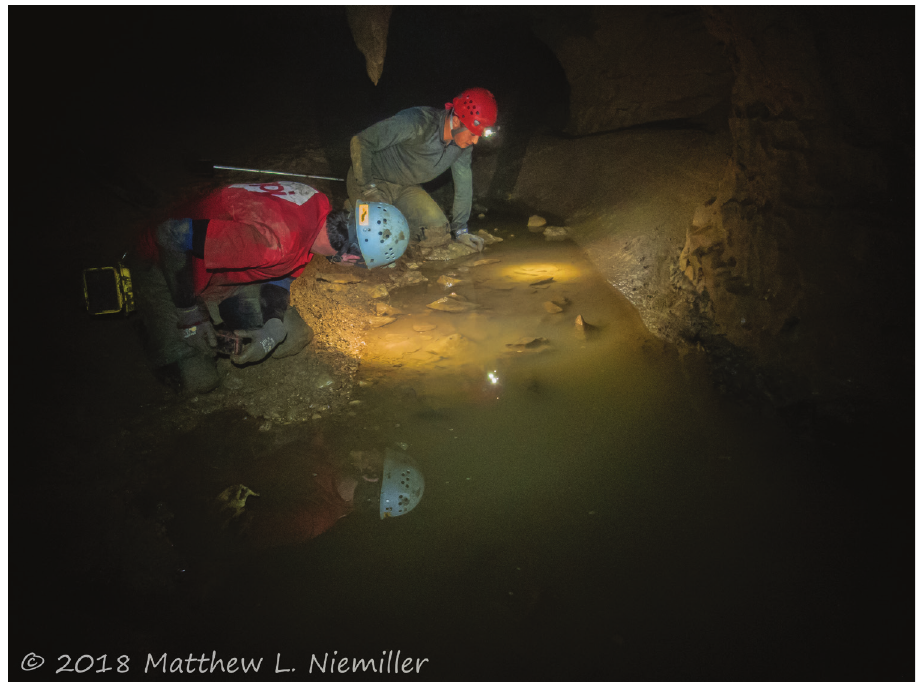
Figure 3. Joe Lamb and Bradley Jones searching for cave shrimp in an isolated pool near the Davidson Entrance to Fern Cave system on 25 August